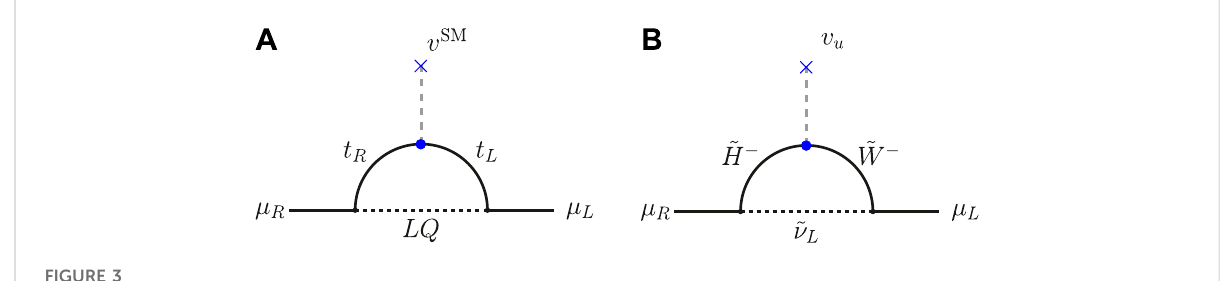
FIGURE 3 Concrete instancesofthegenericdiagramsFigure 1foraleptoquarkmodel (A) andsupersymmetry (B) .Thediagrams correspondto theresults (35.36) and (43.44),